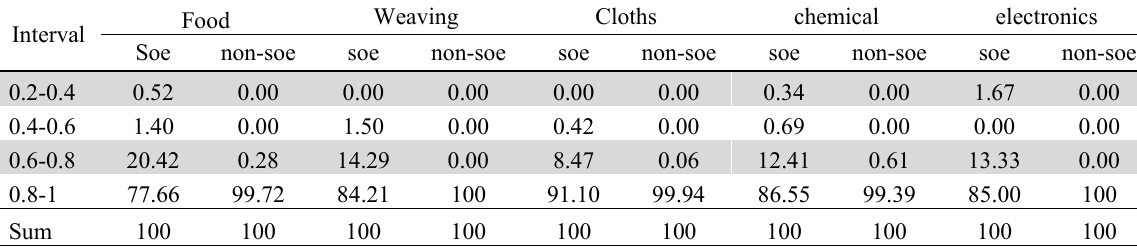
Technology gap ratio by ownership and by sub-industry, 2011 Food Weaving Cloths chemical electronics Interval Soe non-soe soe non-soe soe non-soe soe non-soe soe